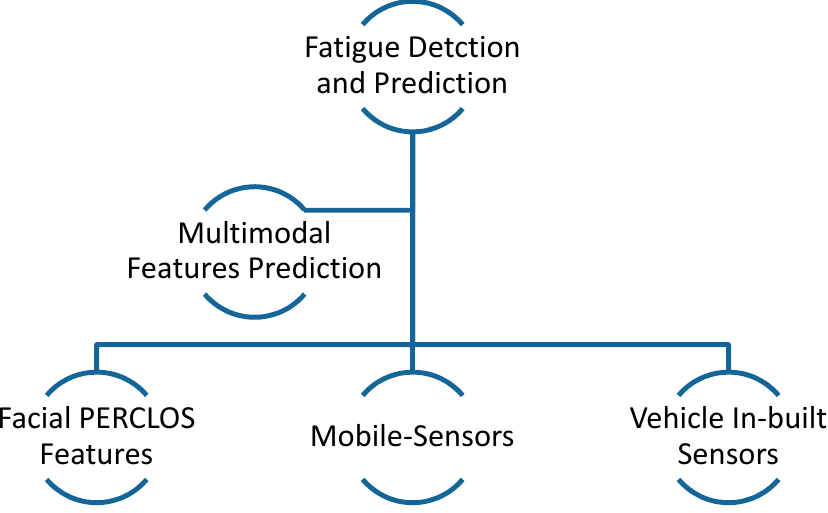
Figure 1. A visual example shows the multimodal features for detecting of driver fatigue. Multi-sensor and smartphone-based algorithms were developed in recent applications that utilized cloud-based architecture to increase the prediction accuracy of drowsiness. In practice, four discrete patterns (braking, acceleration, left cornering, and right cornering) is easily determined by smartphones with a low-cost solution. Commercially